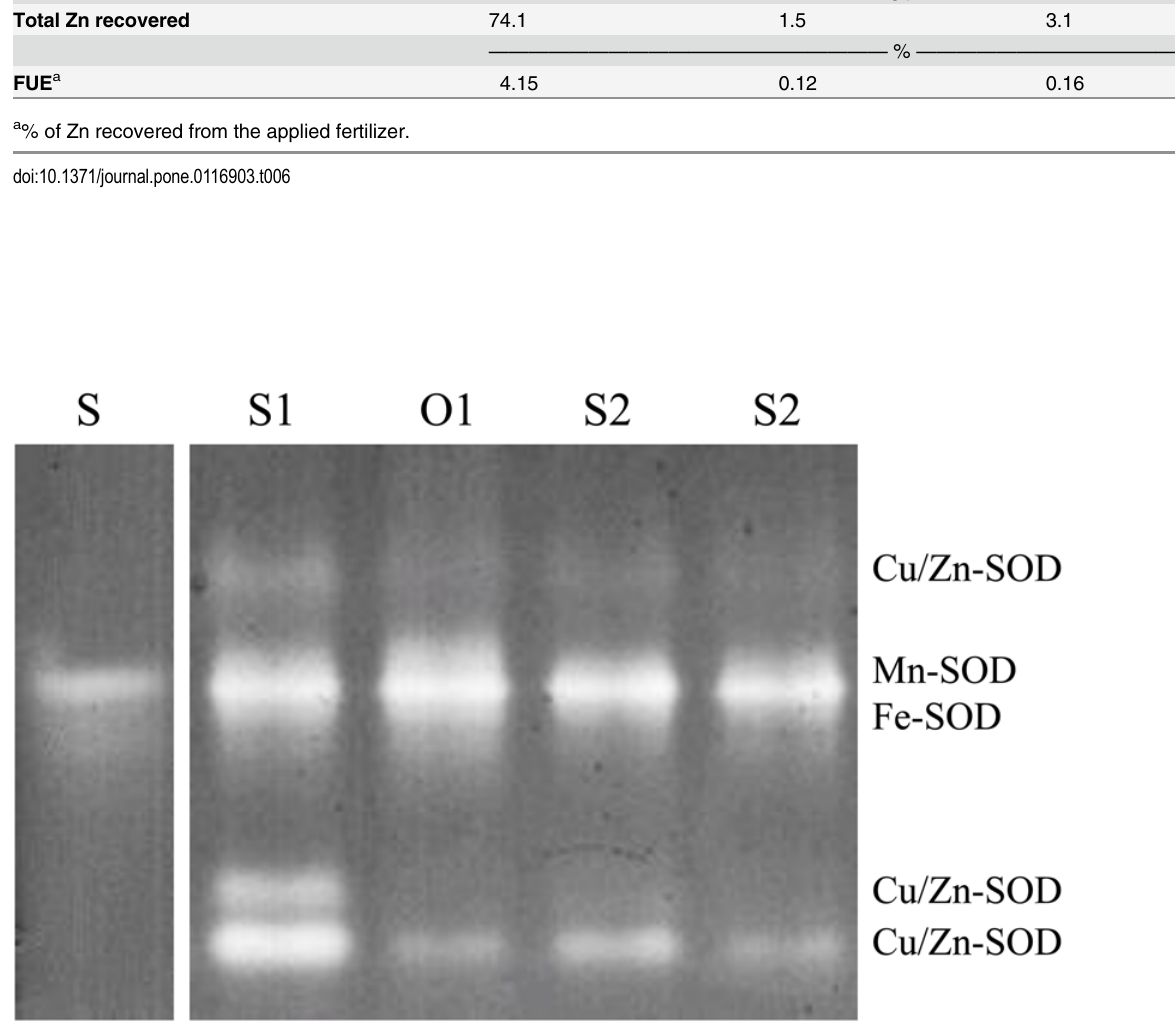
Fig 1. Superoxide dismutase (SOD) activity in the leaves of young orange trees 150 days after Zn application (enriched on 68 Zn) in different soils. Legend: Bovine SOD standard (S), ZnSO 4 (S1), and ZnO (O1) in the sandy loam soil; ZnSO 4 (S2) and ZnO (O2) in the clay soil.